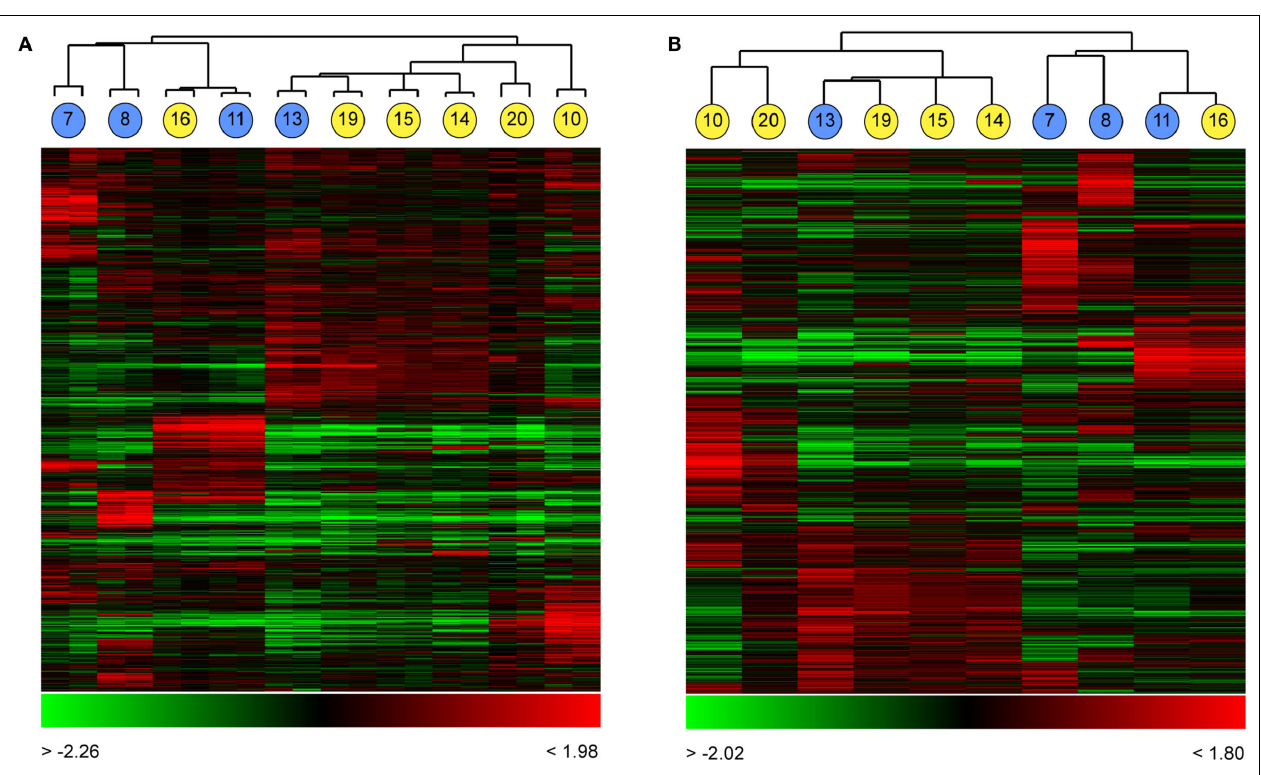
FIGURE 4 | Grouping single cortical neurons by their global expression profi les. Ten neurons from layer II/III of somato-sensory cortex of young mice (P13–P22) were recorded from and expression profi led as described ( Figure 1 and Materials and Methods). Cells were clustered based on Pearson correlation coeffi cients as a measure of similarity in gene expression. Clustering of these cells without averaging gene expression between the dye-swapped technical array replicates (A) resulted in the formation of two distinct clusters containing primarily fast-spiking neurons (yellow circles) or regular spiking neurons (blue